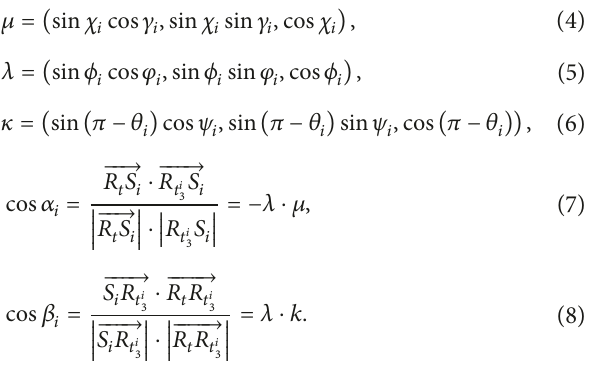
estimate sound speed by measuring salinity, temperature, and depth